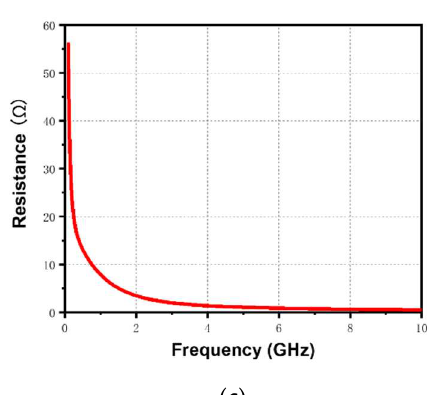
Figure 3. Simulation results of the ( a ) capacitance, ( b ) inductance, and ( c ) resistance of the optimized center capacitor.